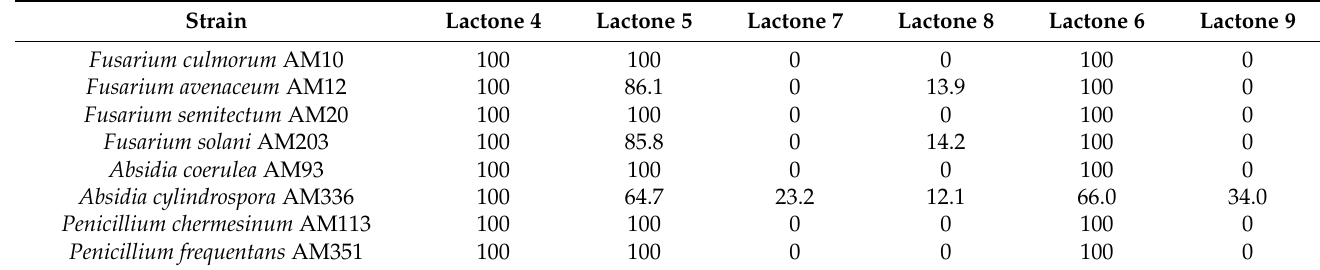
Table 1. Results obtained from screening biotransformation of lactones 4 – 6 after 7 days of incubation (in percentage according to